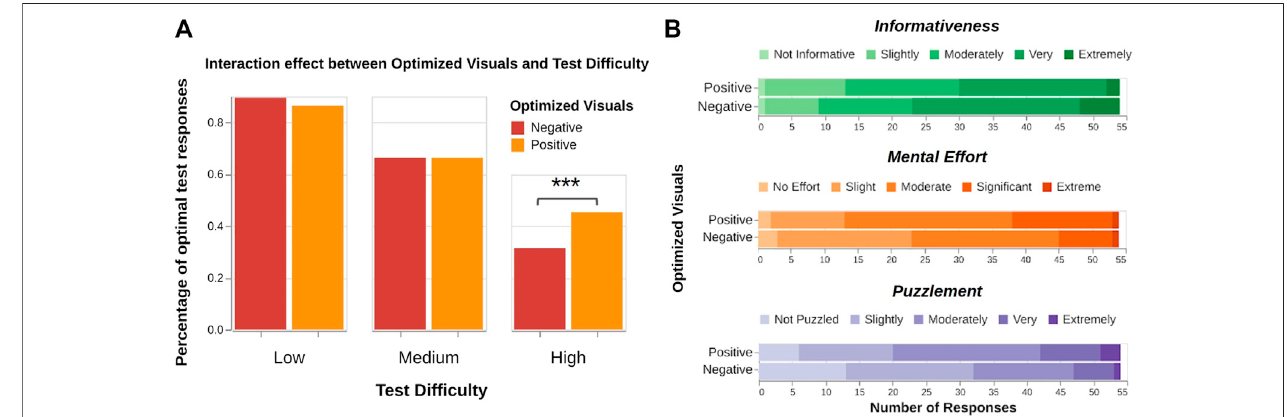
FIGURE 7 | (A) Optimizing teaching demonstration visuals does not signi fi cant affect performance on low and medium dif fi culty tests, but leads to a signi fi cant improvement on high dif fi culty tests. (B) Ratings on mental effort and puzzlement surprisingly increased for positive visual optimization, likely an artifact of unforeseen study design effects. No signi fi cant effects were found for ratings on